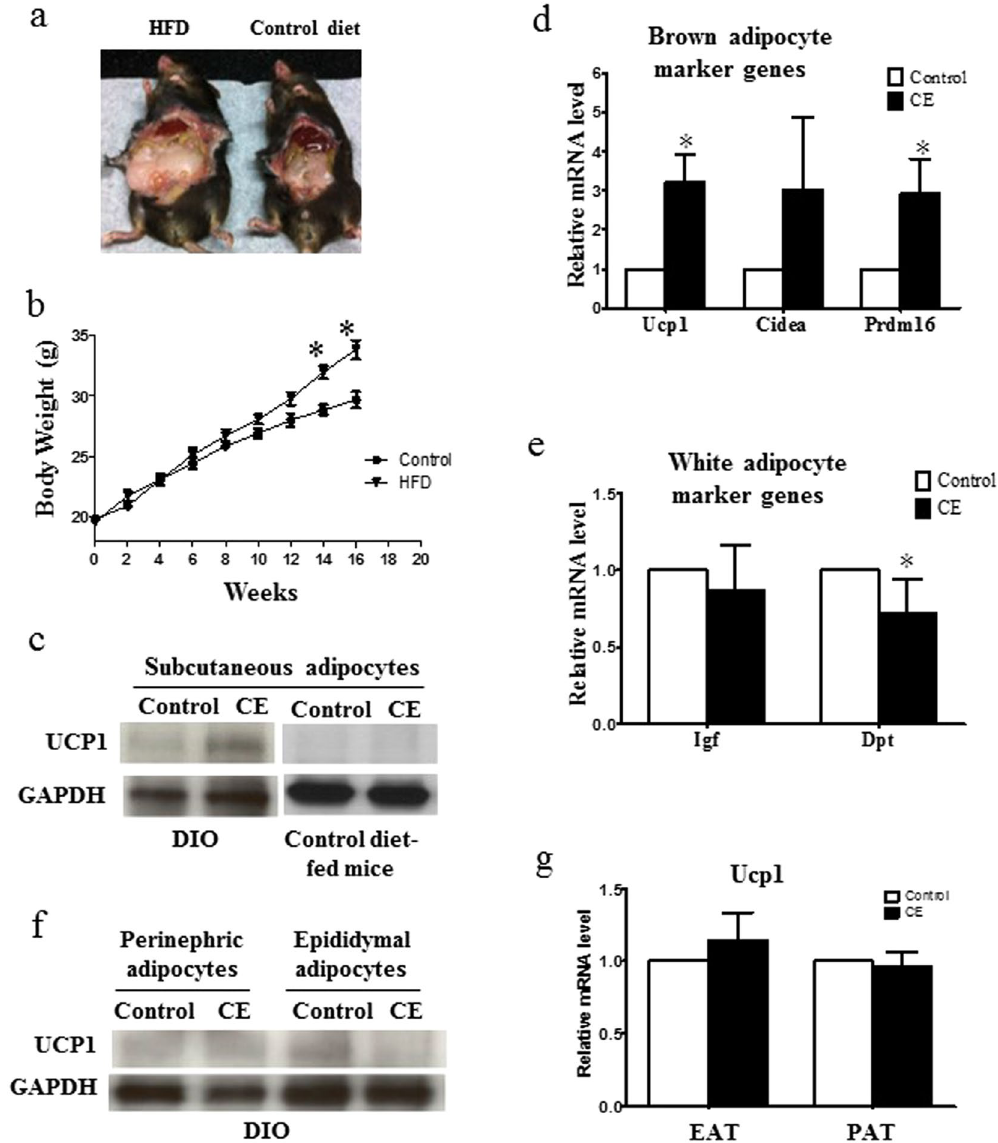
Figure 6. ( a ) High fat diet (HFD)-induced obesity mouse (DIO) and matched control diet-fed mouse. ( b ) Body weights of DIO mice and control diet-fed mice. ( c ) UCP1 protein expression in subcutaneous adipocytes isolated from the DIO mice and control diet-fed mice. ( d ) Expressions of brown adipocyte marker genes and ( e ) white adipocyte marker genes in subcutaneous adipocytes isolated from the DIO mice. ( f ) Protein expression and ( g ) mRNA expression of UCP1 in perinephric adipocytes (PAT) and epididymal adipocytes (EAT) isolated from the DIO mice. CE, cinnamon extract (80 µ g/ml). Ucp1, uncoupling protein 1; Cidea, cell death-inducing DFFA-like effector A; Prdm16, PR domain containing 16. * p < 0.05, n = 3 individual